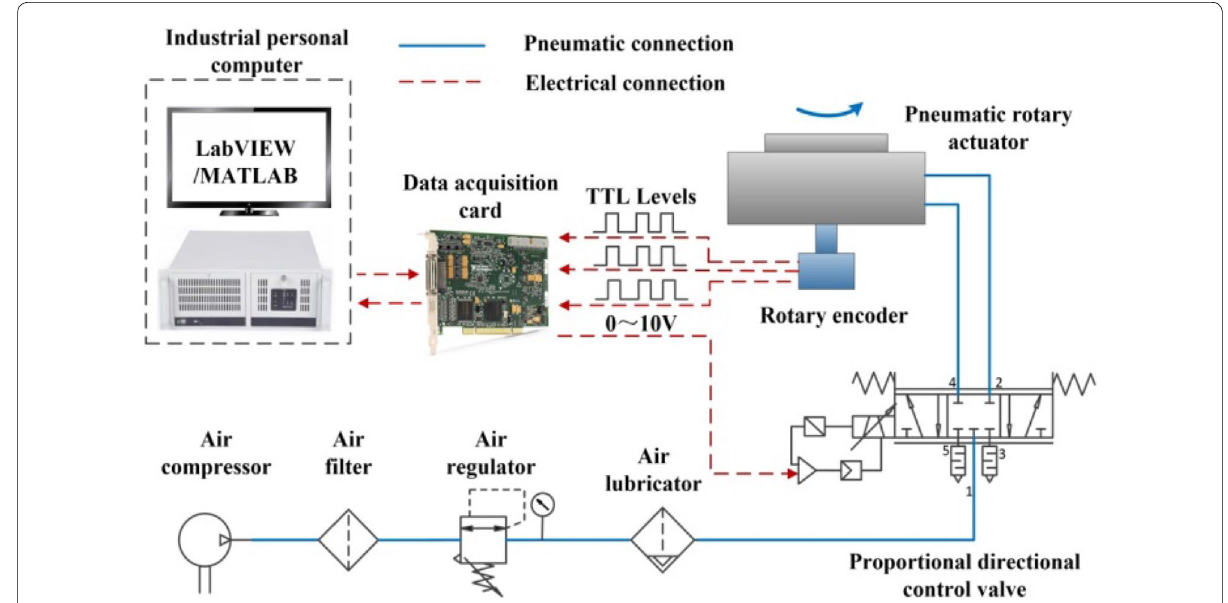
Figure 1 Schematic diagram of the pneumatic rotary actuator servo-control system